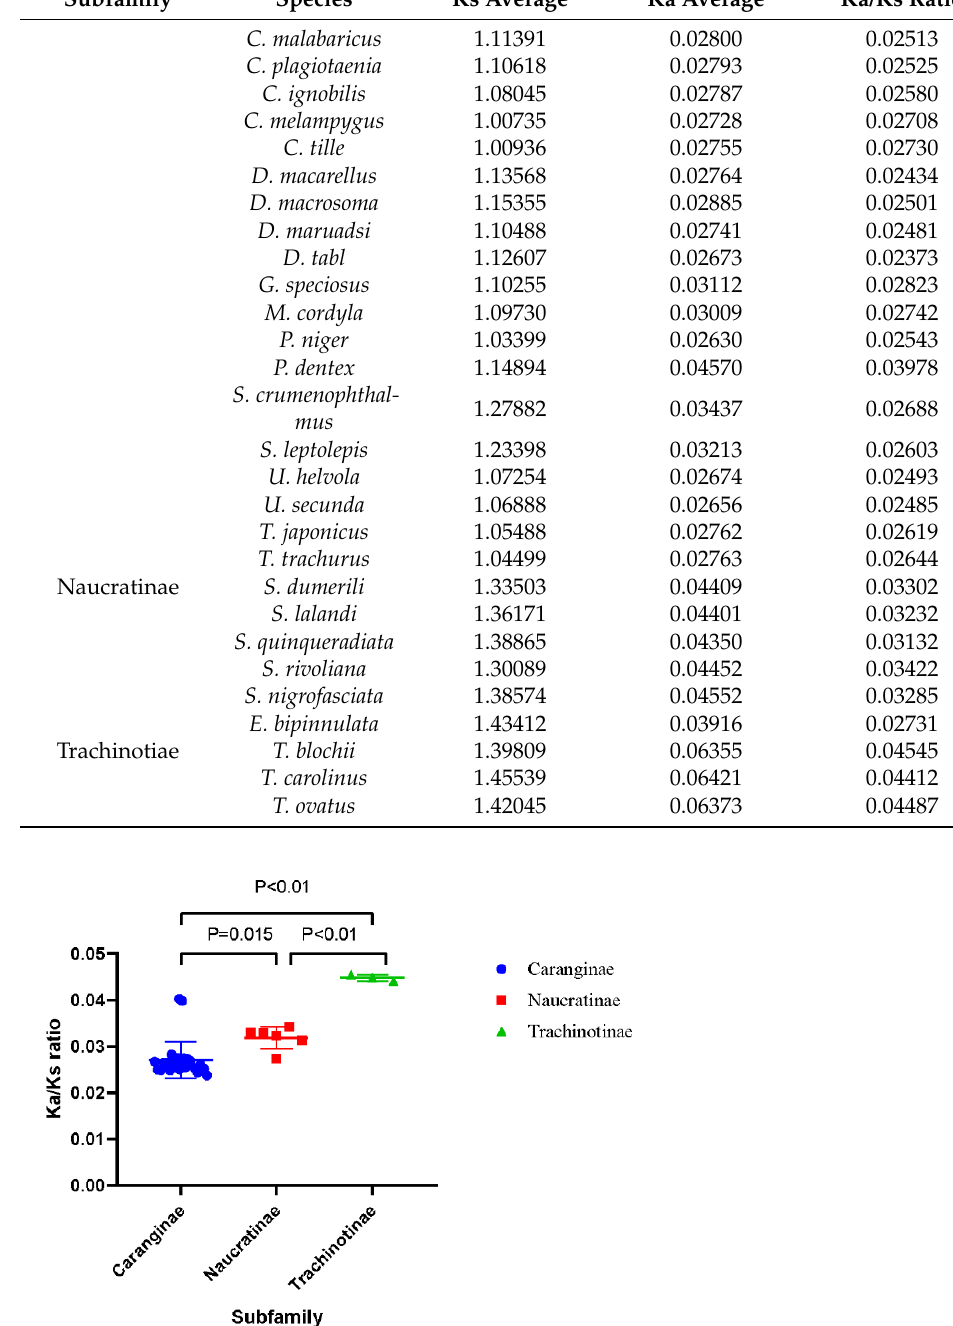
Figure 4. Plot of the individual Ka/Ks ratio values of three subfamilies. Table 4. The mean values of the Ka/Ks ratio for the PCGs in the pairwise mitochondrial genome among the Carangidae fishes.